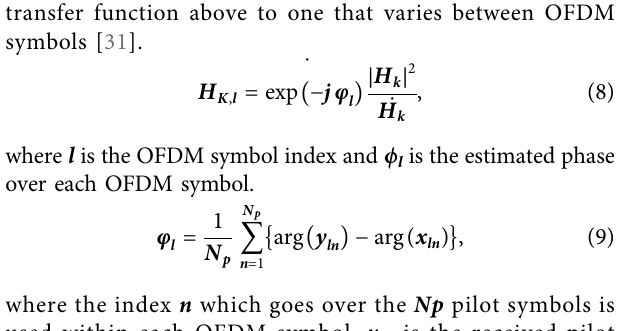
Frontiers in Physics |